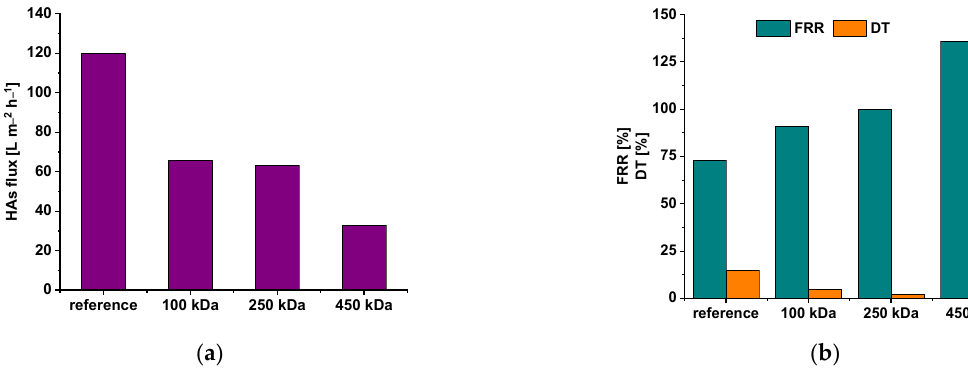
( b ) Figure 9. The dependence of 0.5 wt.% lysozyme solution flux ( a ) (J Lys ) and lysozyme rejection coef ‐ ficient ( b ) (R Lys ) on the PAA concentration in the coagulation bath. 3.7. Effect of the PAA Molecular Weight and Concentration in the Coagulatin Bath on the Membrane Antifouling Performance Membrane antifouling performance was investigated during ultrafiltration of HAs solution in tap water with subsequent cleaning by filtration of distilled water. PAA ‐ 100 ‐ 1.5, PAA ‐ 250 ‐ 1.5 and PA ‐ 450 ‐ 1.5 membranes were selected for this experiment